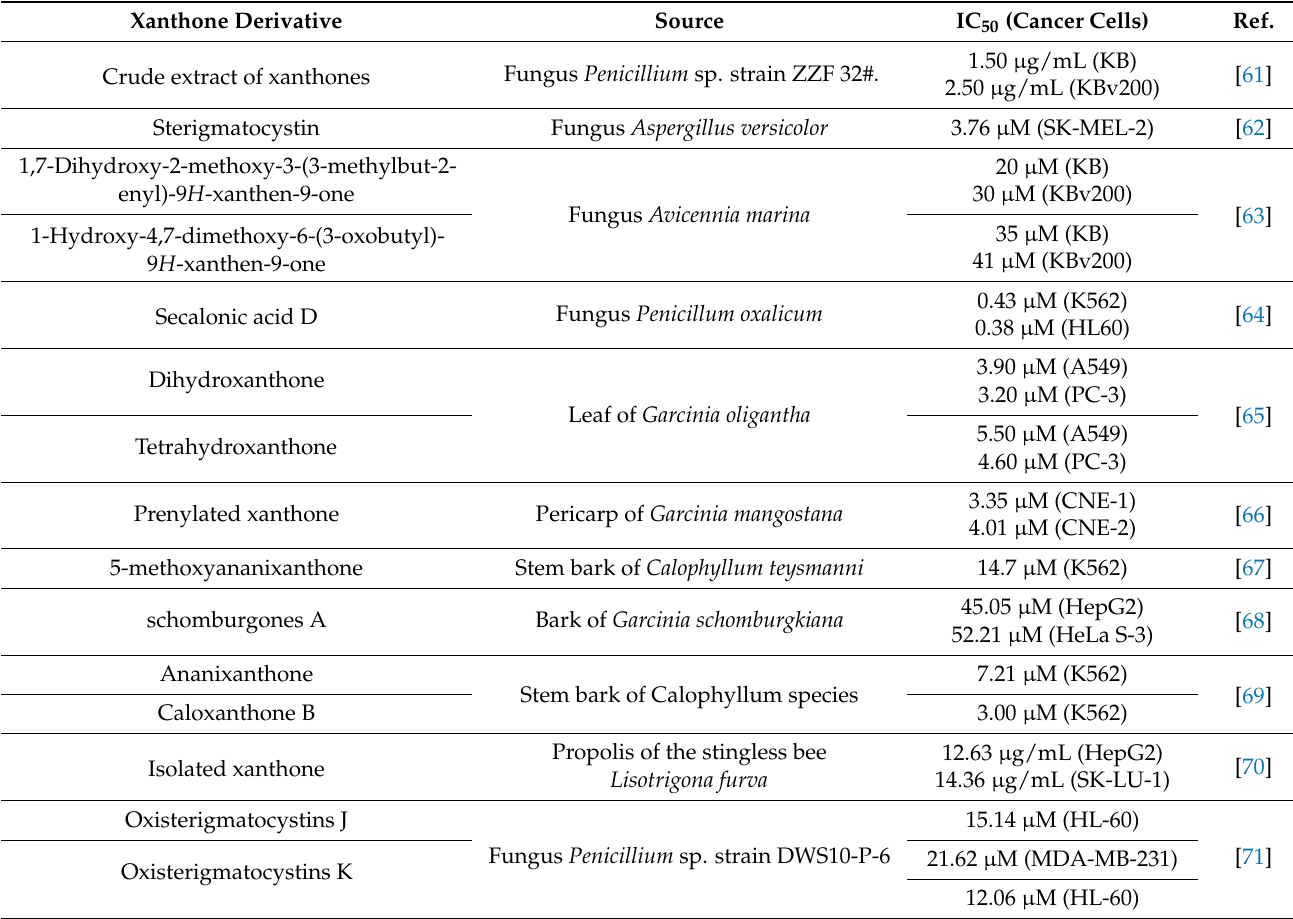
Table 2. Summary of the anticancer activity of isolated xanthone